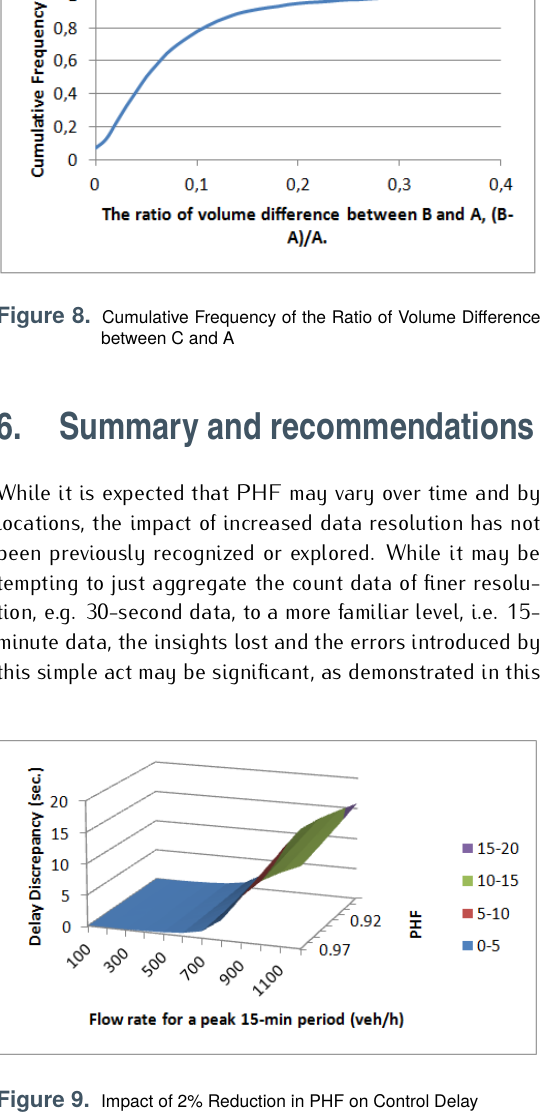
Figure 10. Impact of 5% Reduction in PHF on Control Delay paper. Both non-aggregated approaches, constrained